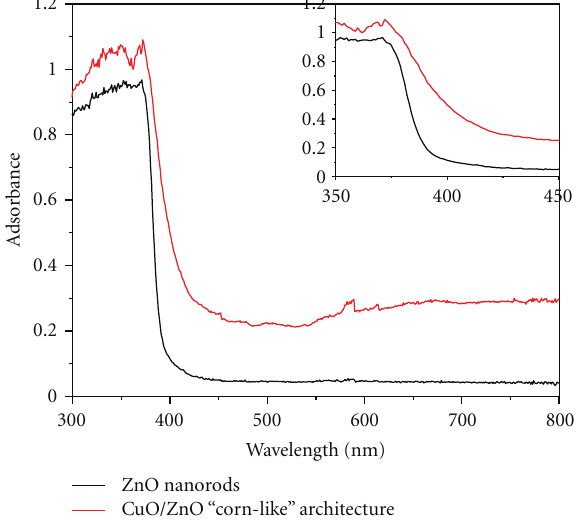
Figure 5: The UV-visible spectra of the hierarchical CuO/ZnO nanomaterials and ZnO